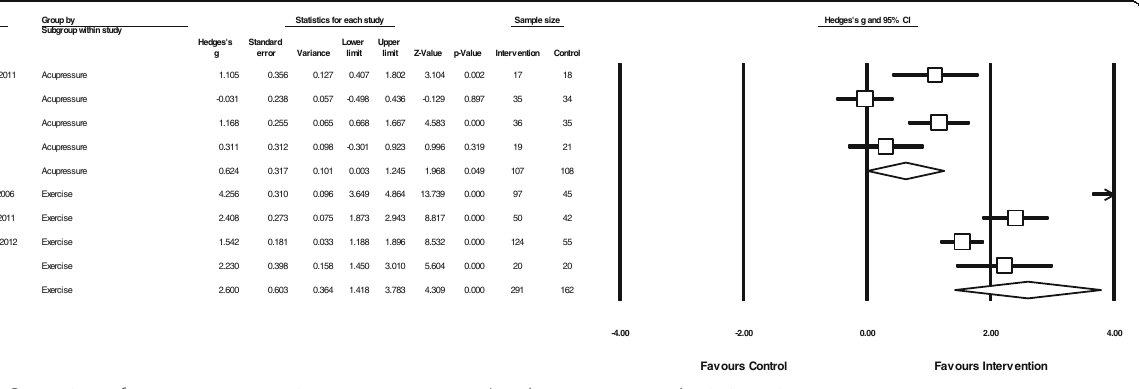
Fig. 7 Comparison of acupressure or exercise versus no treatment/usual care on menstrual pain